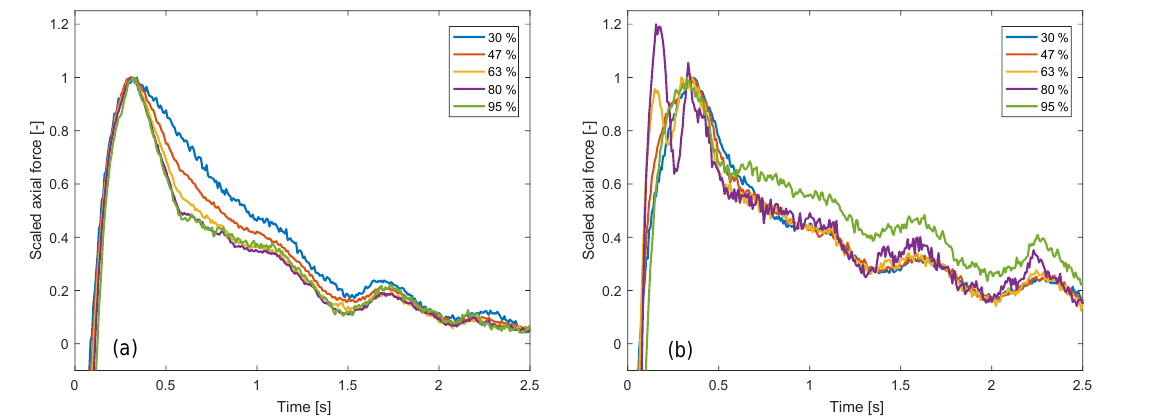
Figure 1. Scaled axial force measurements from the Phase VI experiment at 5ms − 1 . The pitch steps are deloading the rotor (induction factor from a = 0 . 5 to a = 0 . 0, a ) and loading the rotor ( a = 0 . 0 to a = 0 . 5, b ).